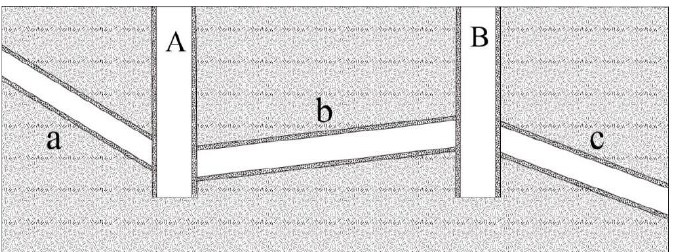
Figure 3. Pipeline with flow direction opposite to slope. Where, A and B represent nodes; a, b and c represent pipeline.